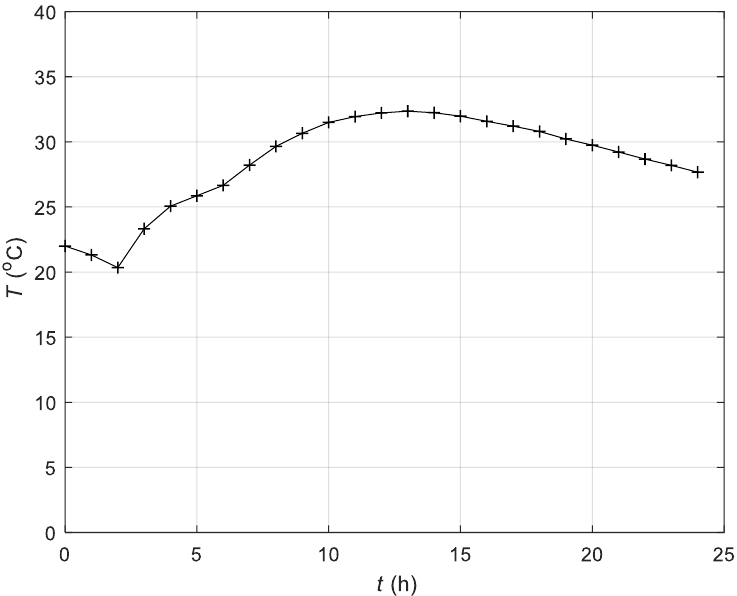
Figure 9. Time course of bioreactor temperature required to control the fermentation process.